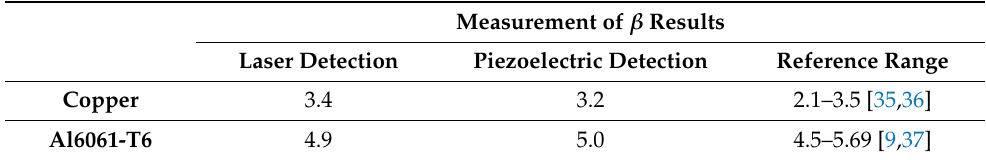
Table 2. Measured absolute parameters ( β Cu ) and ( β Al